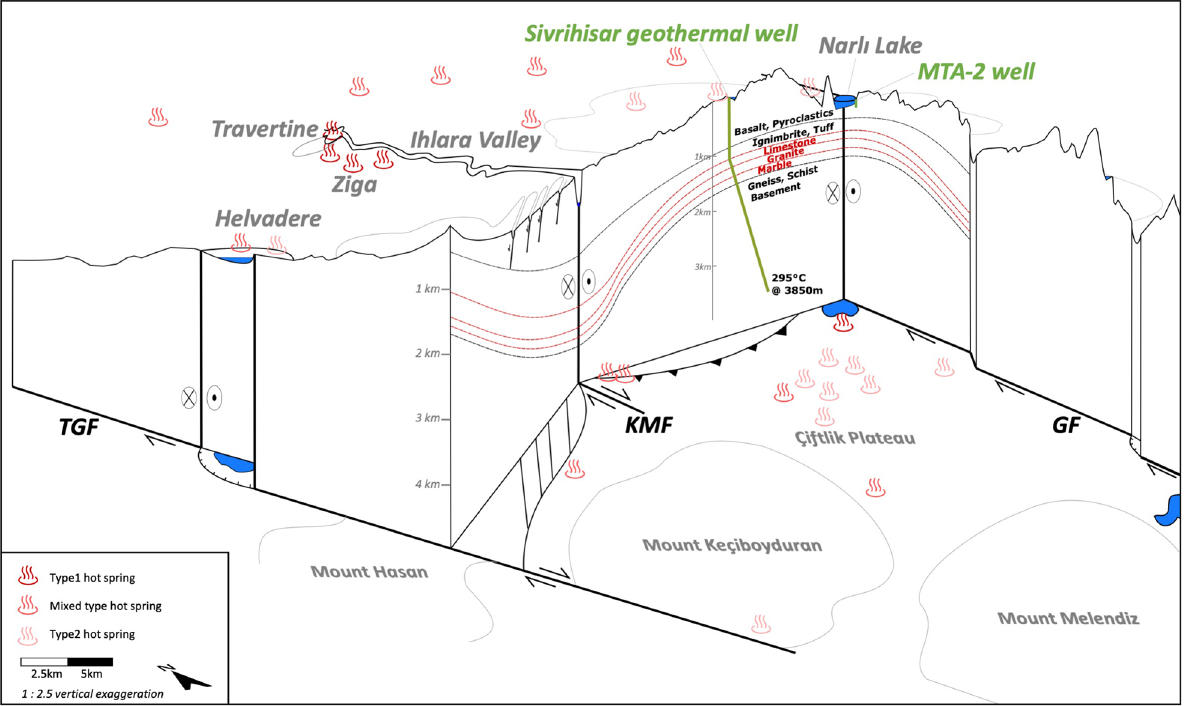
Figure 4. Sketch of structural-geological setting according to Fig. 1 with subsurface data from Burcak 12 . Suggested geothermal reservoir in limestone, granite and marble (red) and hot spring